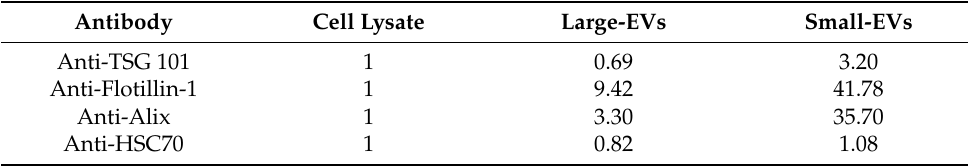
Figure 1. ( A ). Particle size distribution of small- and large-EVs isolated from cultured primary neurons by Nanopartical tracking analysis showing the size versus concentration of particles. ( B ). The Western blot analysis of characteristic markers of EVs. The characteristic markers (Alix, TSG101 and Flotillin) were more highly expressed in S-EVs than L-EVs and neuronal cell lysate. Band intensity was analyzed by ImageJ software as shown in Table 2. Table 2. Quantification for Western